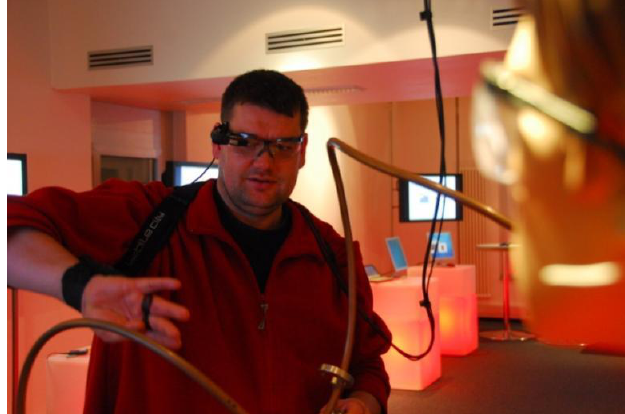
Fig. 3. Touching and trying latest